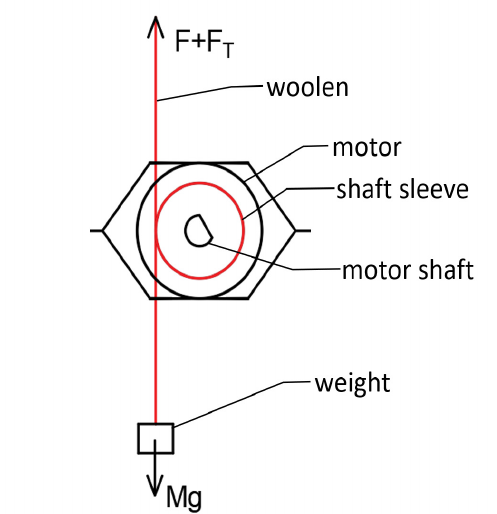
Figure 10. Schematic diagram of torque test